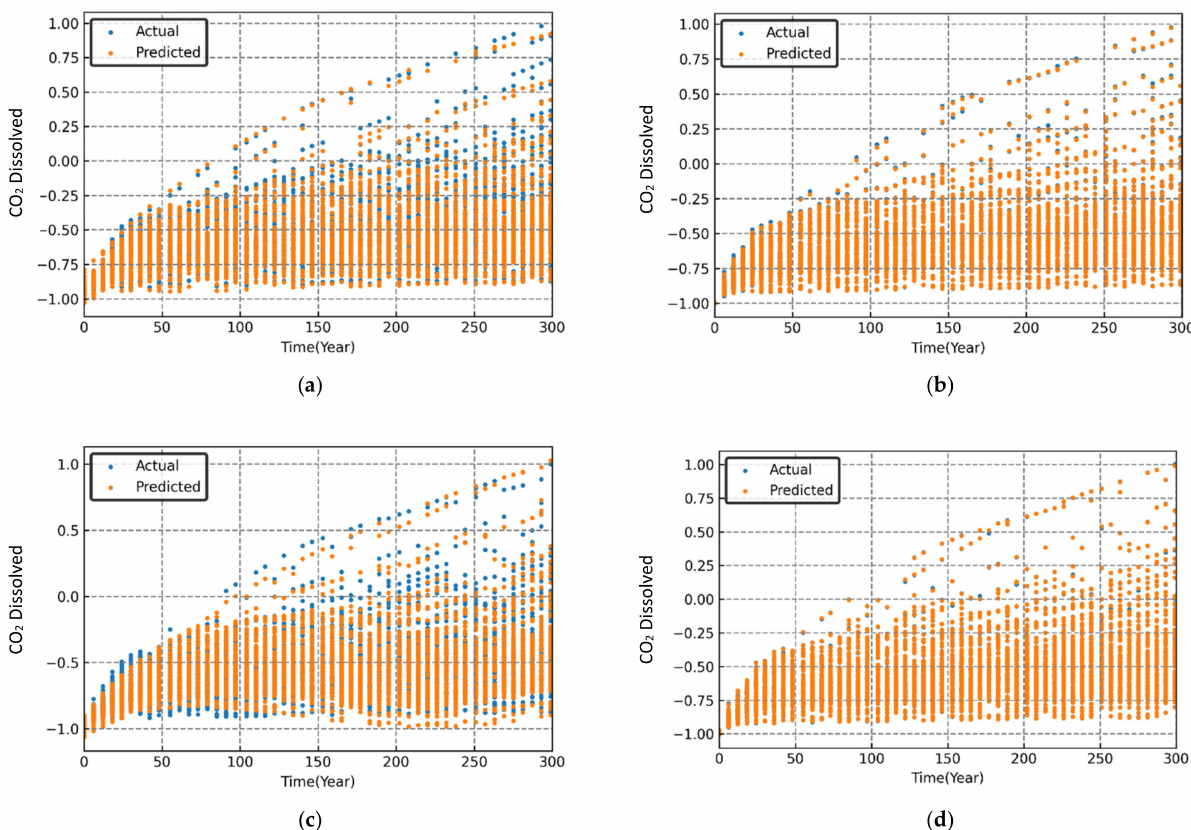
Figure 9. Variation in simulated and predicted dissolved CO 2 (normalized) over time for different sets of randomized input parameters. ( a ) MLP; ( b ) RF; ( c ) SVR; ( d )